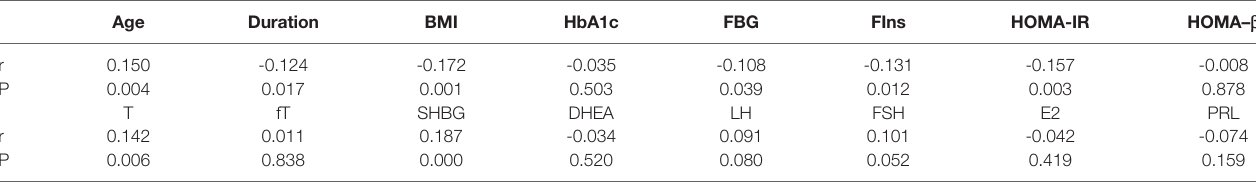
TABLE 3 | Relationship between serum 25(OH)D and age, BMI, sex hormone and glycometabolic parameters. Age Duration r 0.150